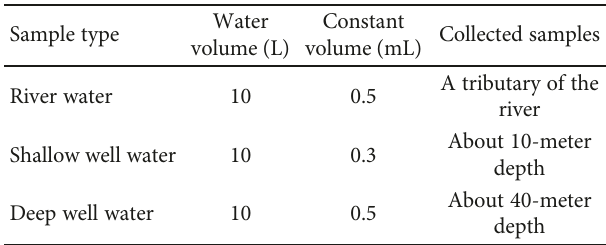
Table 2: The information of the sample point in the Huaihe River Basin of Shenqiu County, Henan